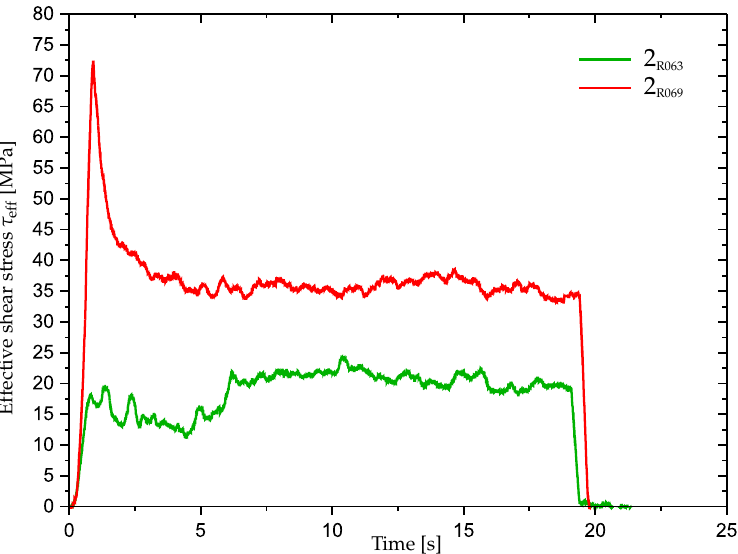
Figure 8. Effective shear stress during the wear transition of two experiments with 2000rpm: 2 with 45MPa, showing rapid transition almost instantaneously after contact; and 2 showing slower transition with a swing-in after about 5 s; both show subsequent stabilization of the